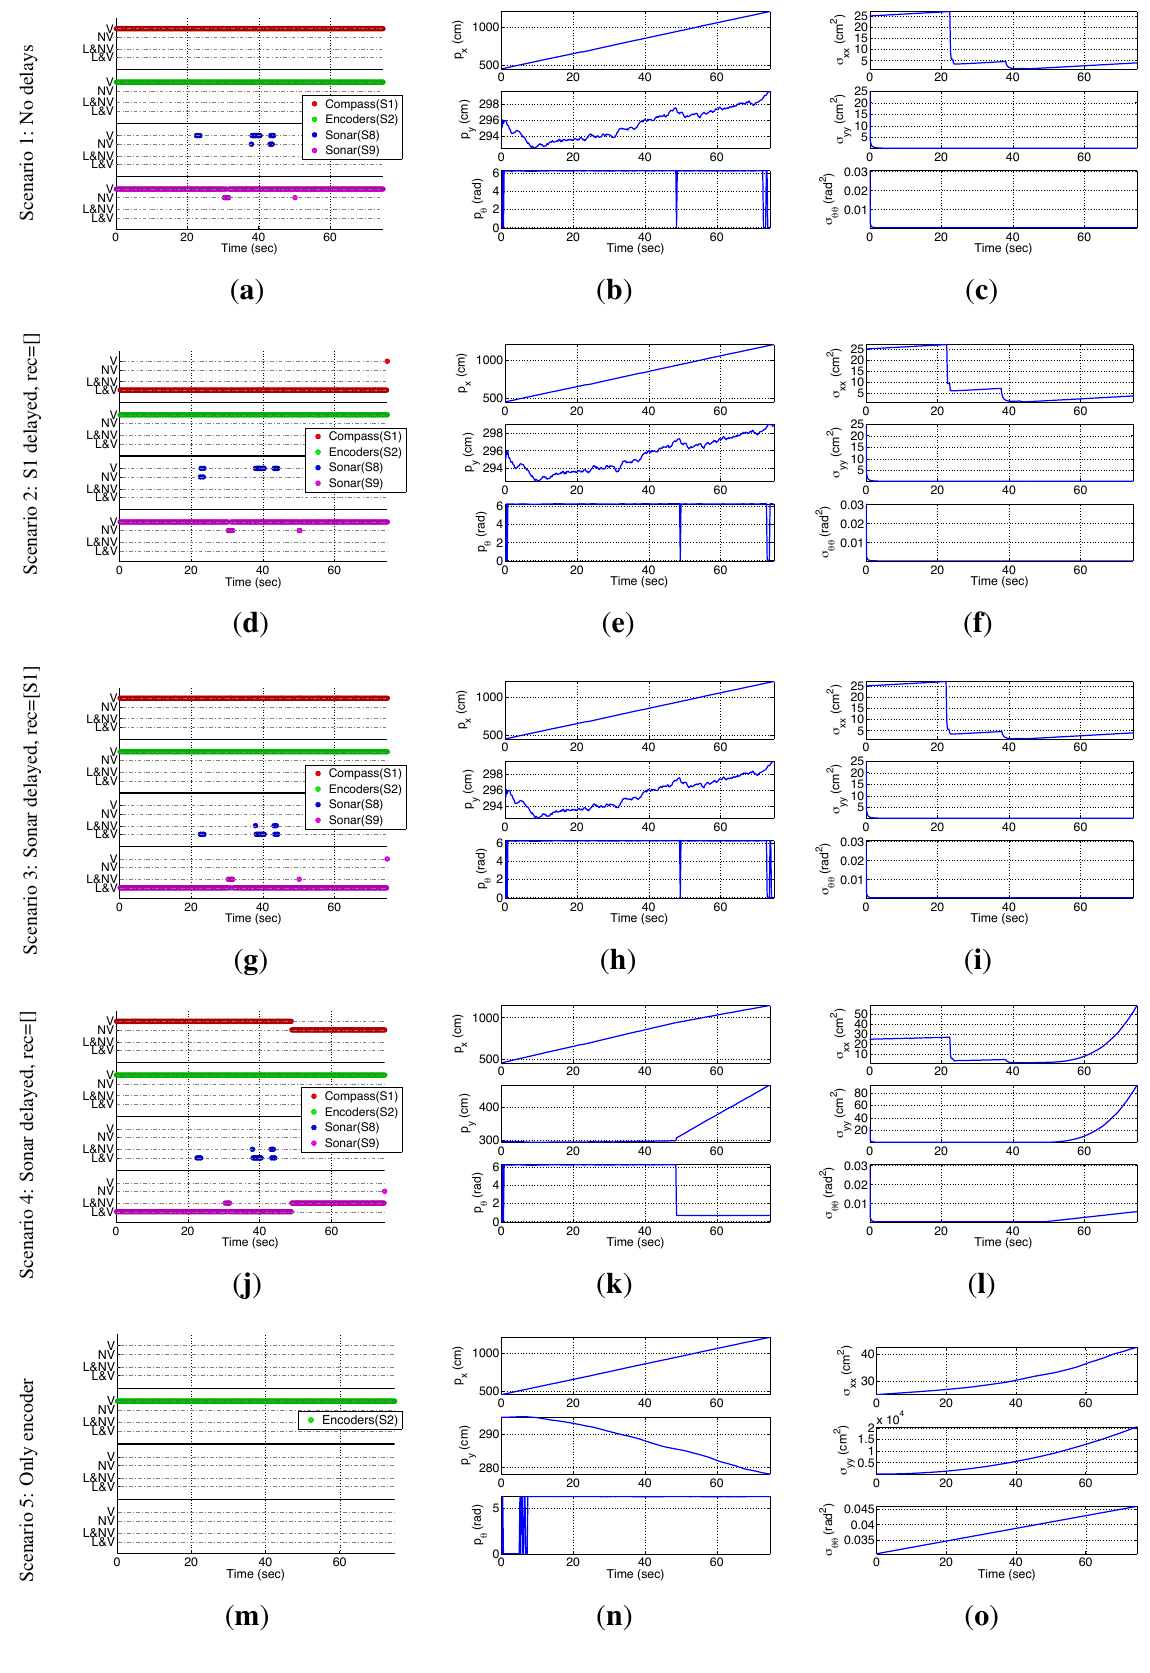
Figure 6. Simulated